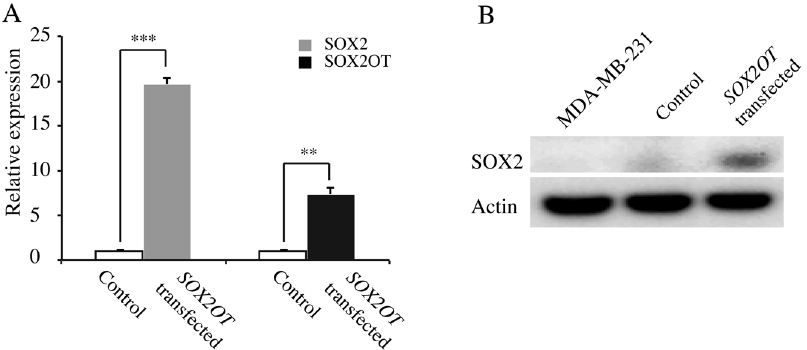
Figure 4. Ectopic expression of SOX2OT in MDA-MB-231 cells. A) Relative expression of SOX2 and SOX2OT measured by qRT-PCR in MDA-MB- 231 cells transfected with control vector and plasmid containing a SOX2OT gene (NR_004053.3). The bar graphs show the fold change relative to control vector. ** and *** represent p values of , 0.01 and 0.001 respectively. B) Western blot analysis showing the over-expression of SOX2 in cells transfected with vector containing the SOX2OT gene.